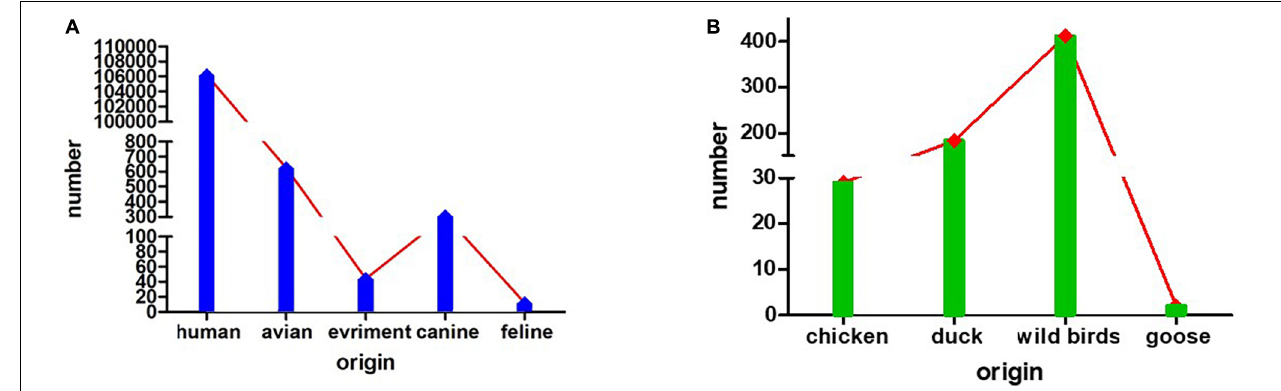
FIGURE 1 | The numbers of isolated H3N2 viruses. (A) The numbers of H3N2 viruses isolated from humans, avians, the environment, canines and felines. (B) The numbers of H3N2 viruses isolated from avians, such as chickens, ducks, wild birds, and geese.